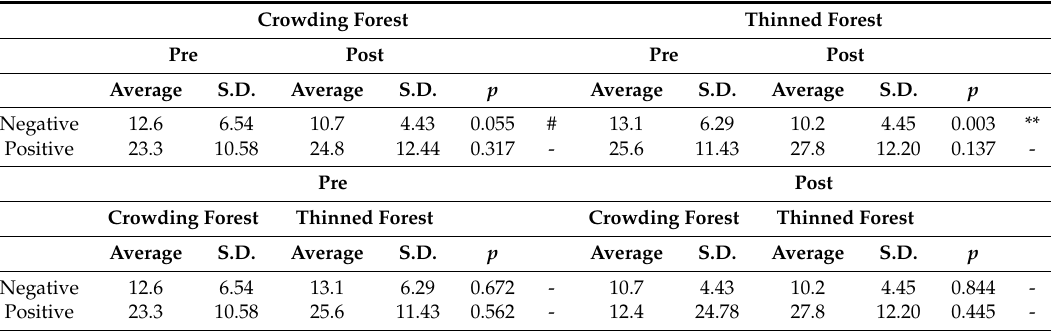
Table 10. Results of multiple comparison tests before and after exposure using the PANAS scores. Crowding Forest Thinned Forest Post